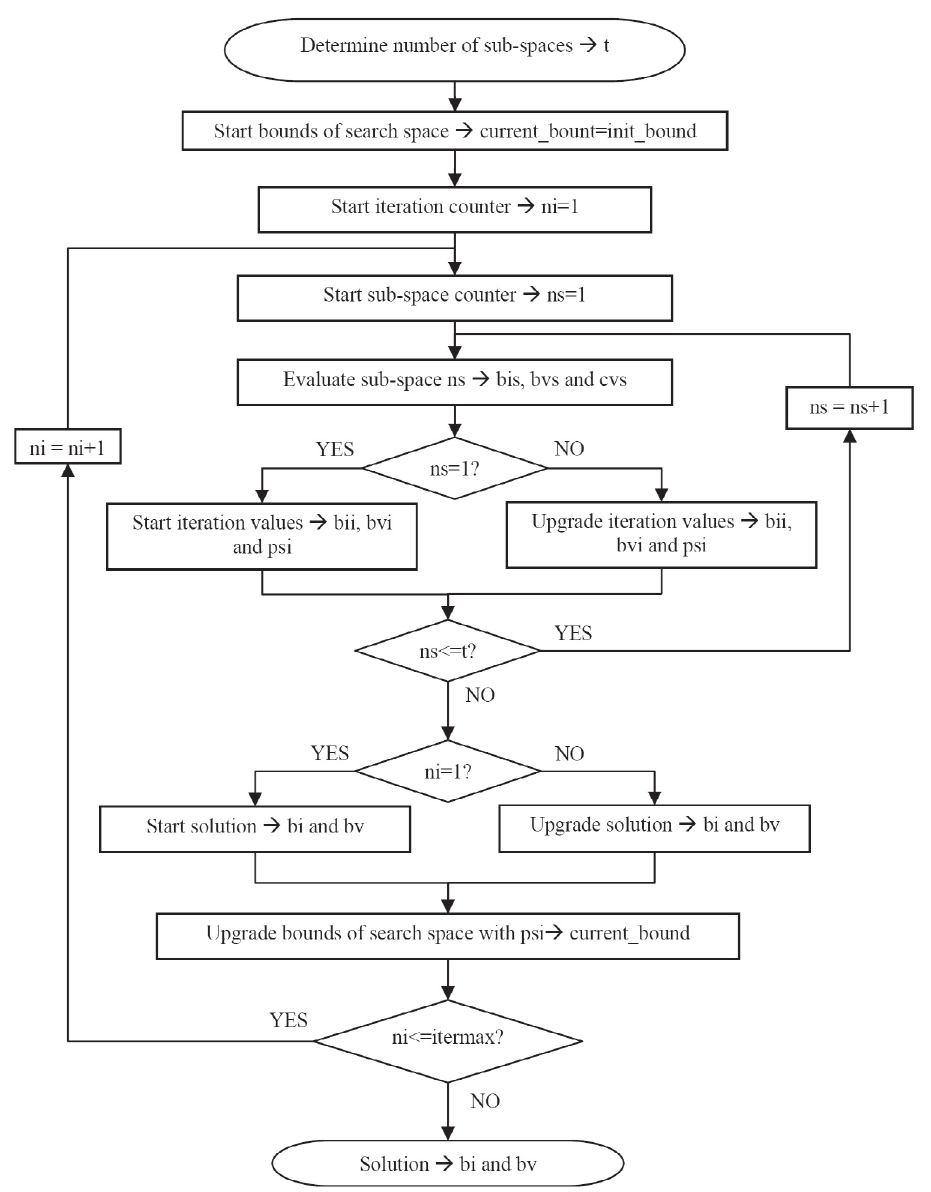
Fig. 3. Flowchart of